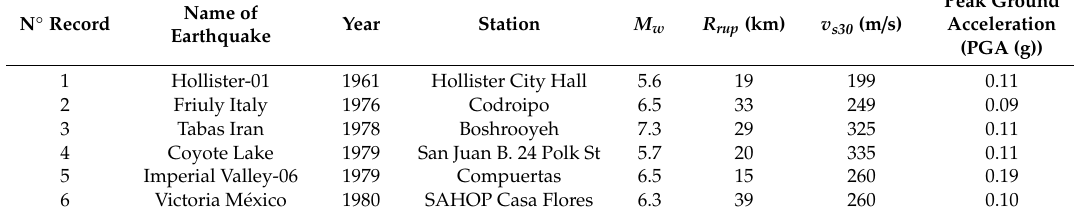
Table 4. Mechanical index of damage ID i of the slit-plate dampers installed in frame.